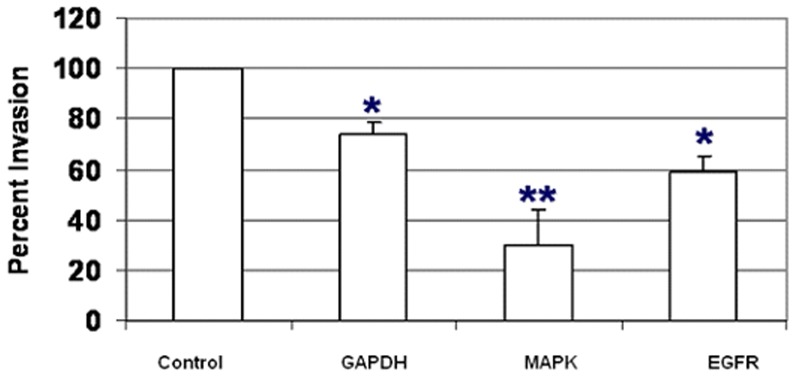
Effect of siRNA Knock-down of MAPK1 on the Invasion of HeLa cells by MAP.HeLa cells were transfected with Glyceraldehyde 3 phosphate dehydrogenase (GAPDH), mitogen activated protein kinase 1 (MAPK1), and Epithelial Growth Factor Receptor (EGFR) siRNAs, infected with MAP, and measured for the effects on invasion. Invasion is given as a percentage relative to the negative control that consisted of HeLa cells incubated with transfecting reagent in serum free medium.